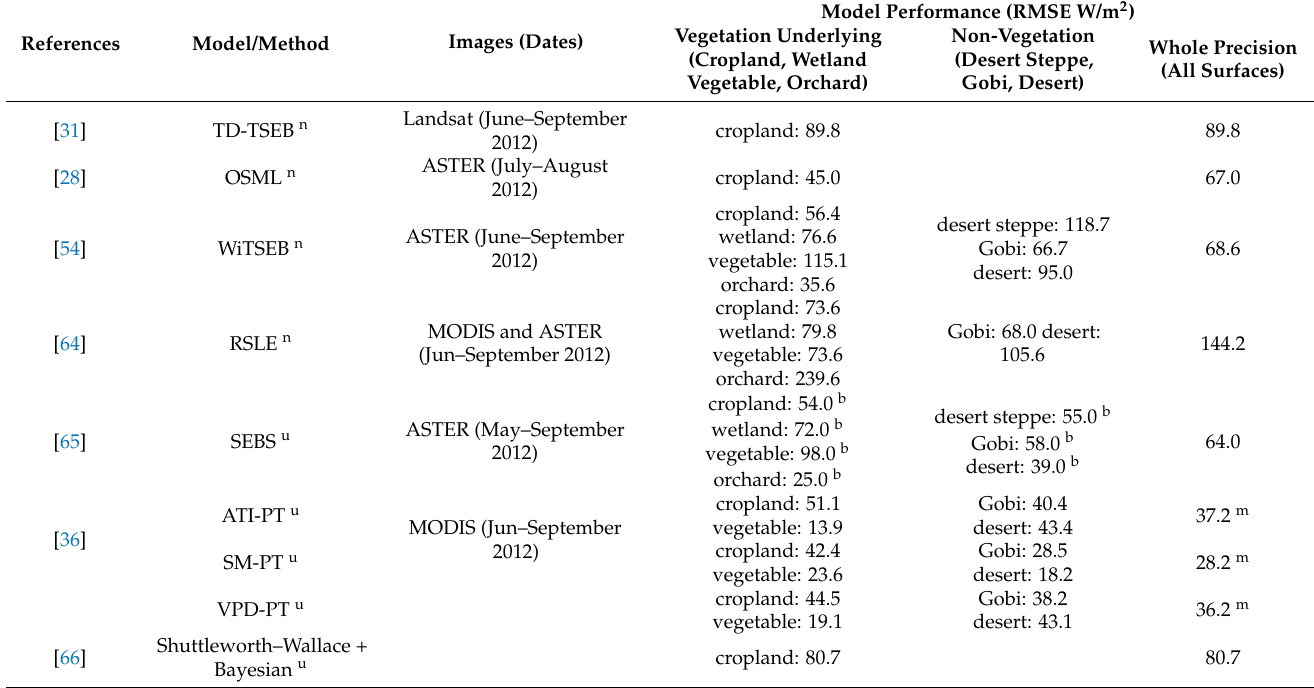
Table 6. Comparison of LE (W/m 2 ) estimation accuracies with different models for different surfaces in the midstream of HRB.